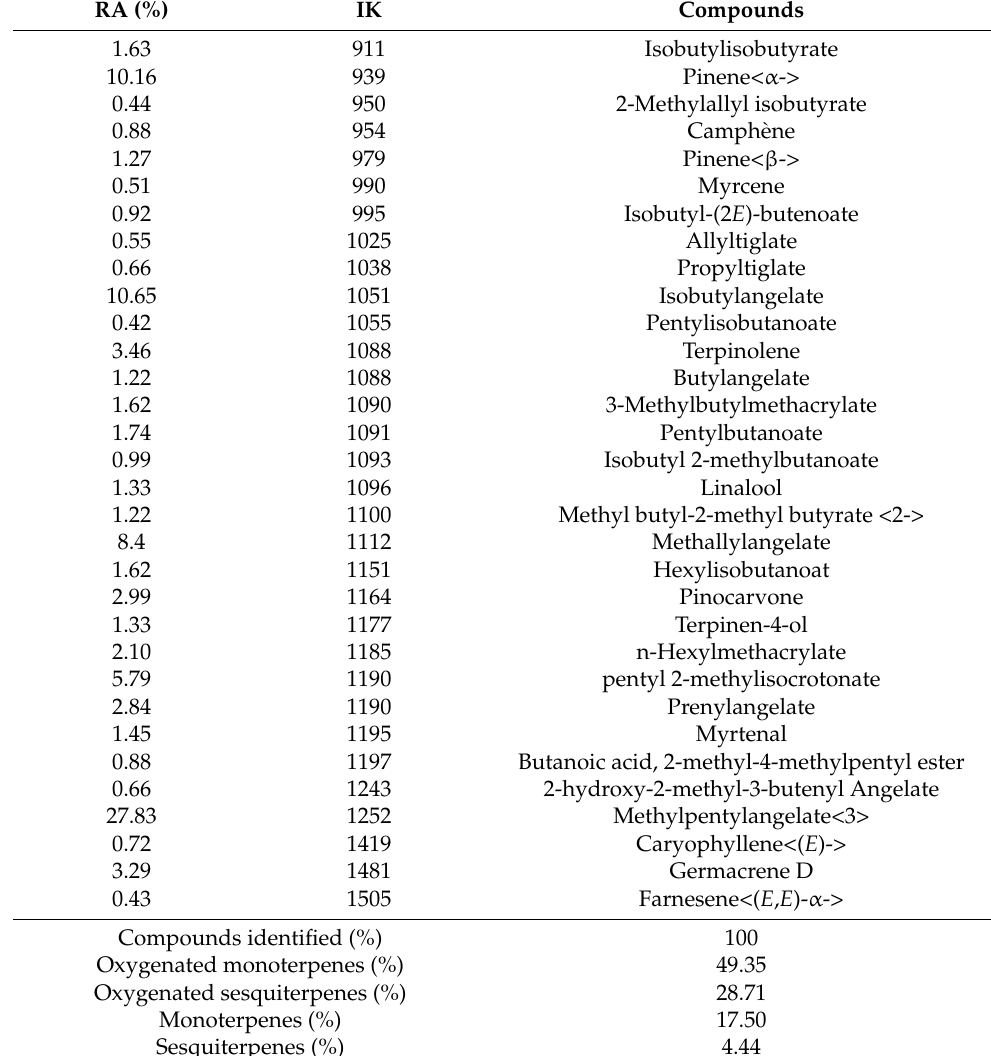
Table 8. The chemical composition of EO of Pistacia lentiscus